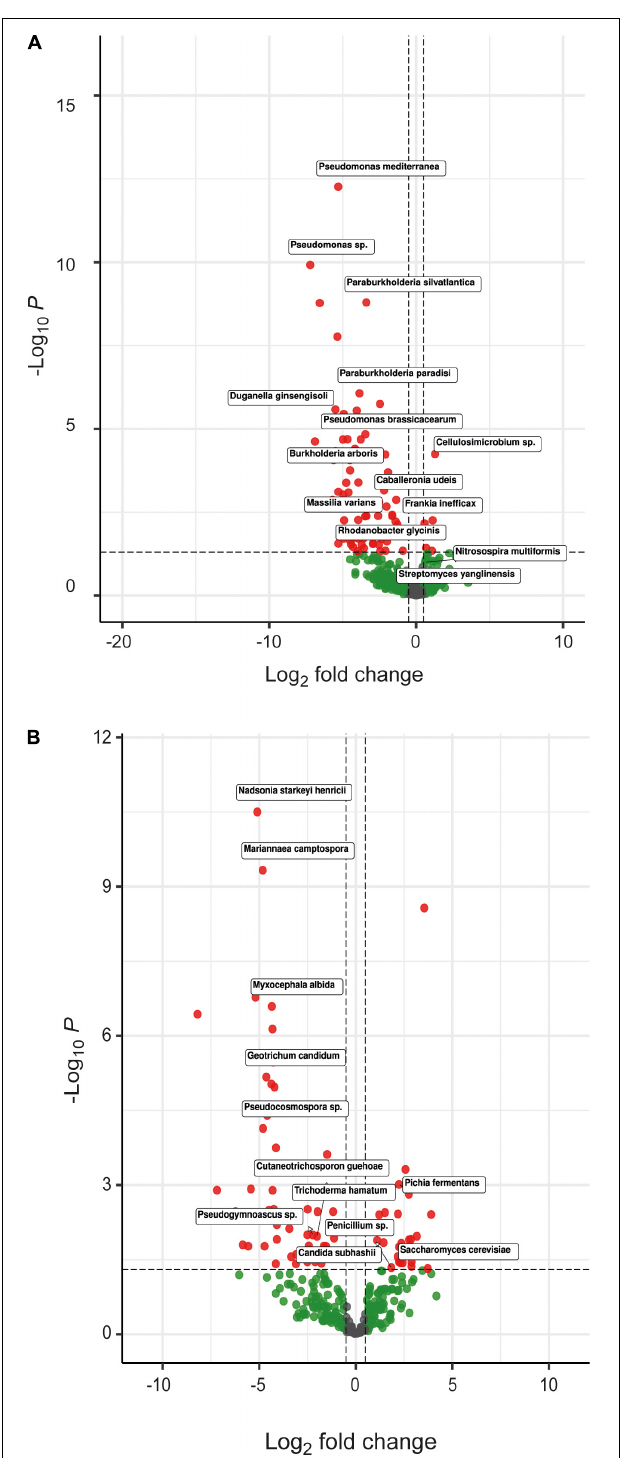
FIGURE 4 | Volcano plot of the differential abundances of microbial profiles at species level, based on DESeq2 results. This plot shows the (A) bacterial and (B) fungal species that were significantly up- and down-regulated by soil application of fungal CFs and DEs (negative and positive log2FC, respectively). Species discussed here are boxed. Thresholds of the volcano plot were established at 0.5 log2Foldchange and 0.05 adjusted p -value (red